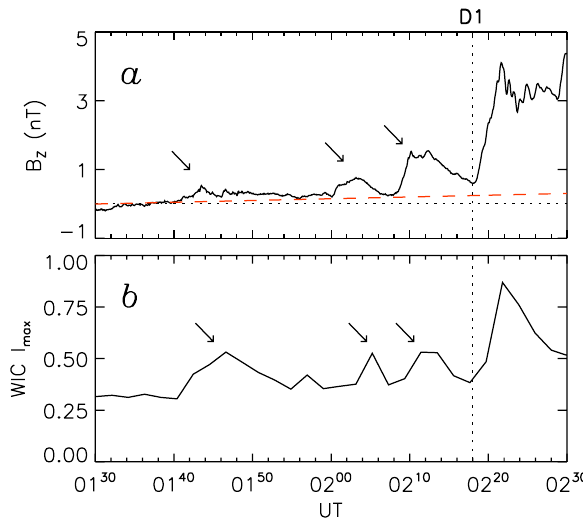
Fig. 9. (a) B z component of the magnetic field at C1 for the interval 01:30 to 02:30 UT, 29 August 2004. (b) Corresponding auroral brightness from IMAGE